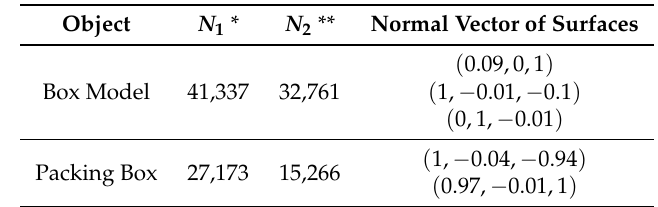
Figure 9. Results of reconstruction and refinement for the box model ( a ), the packing box ( b ), the cylinder model ( c ) and the packing canister ( d ). From left to right (top to bottom): the recovered point cloud, point cloud after being refined and points filtered by refinement. Table 2. Analysis for reconstruction of box objects.